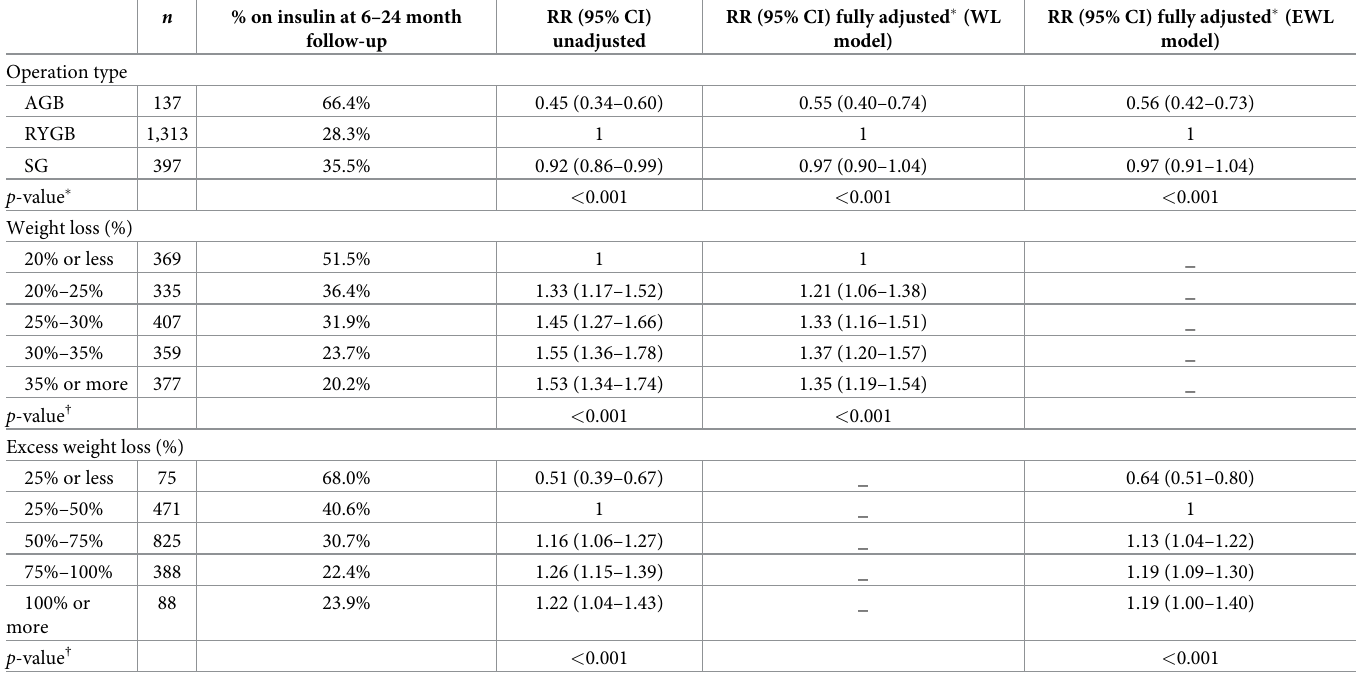
Table 5. Unadjusted and adjusted RRs for insulin cessation at follow-up by subsequent change in weight and procedure ( n = 1,847).